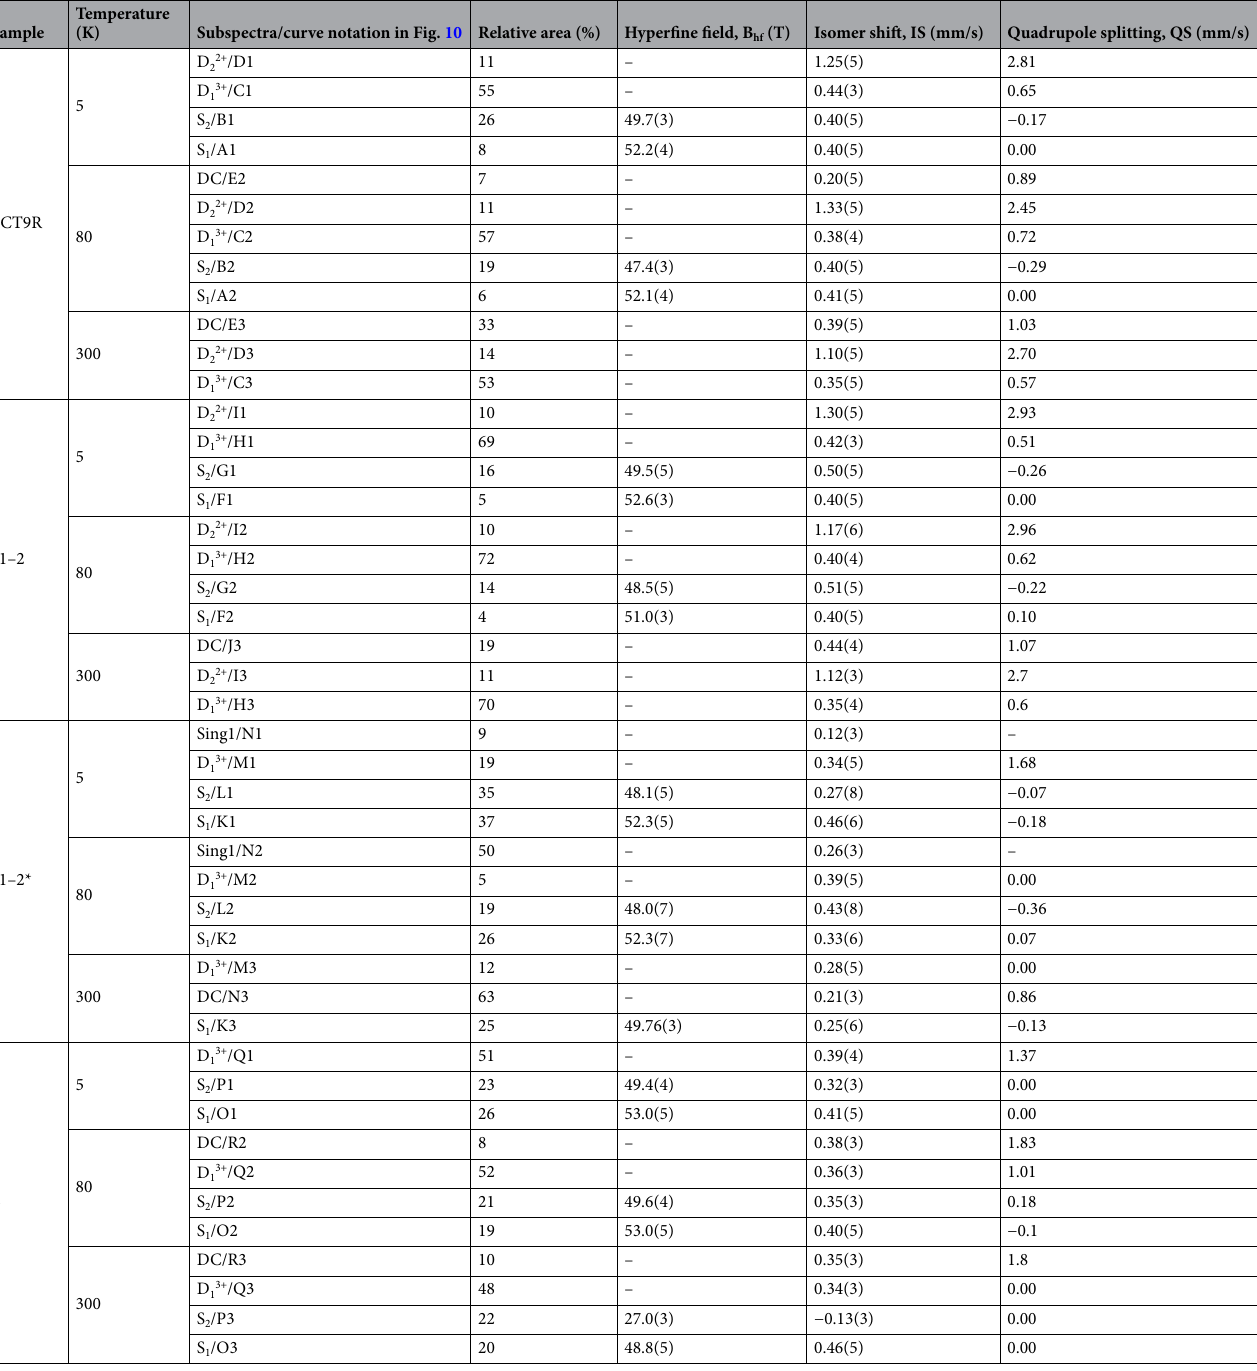
Table 3. Hyperfine parameters from M ӧ ssbauer spectra (Fig. 10). Notations for the M ӧ ssbauer spectral components are S sextet, D doublet, Sing